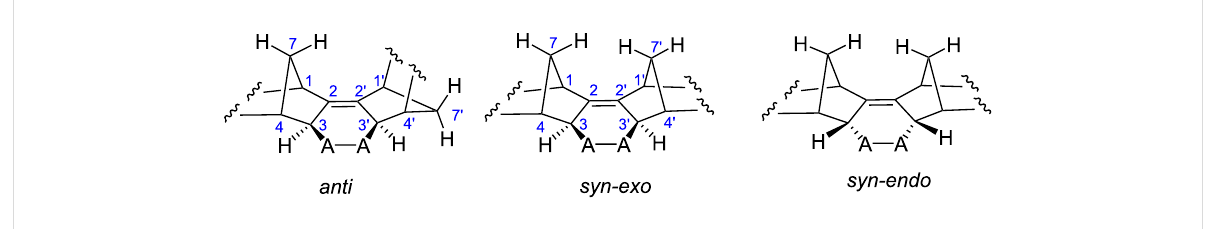
Figure 1: Numbering of carbon atoms and description of possible structures for dimers 11 – 14 and 18 – 21 .